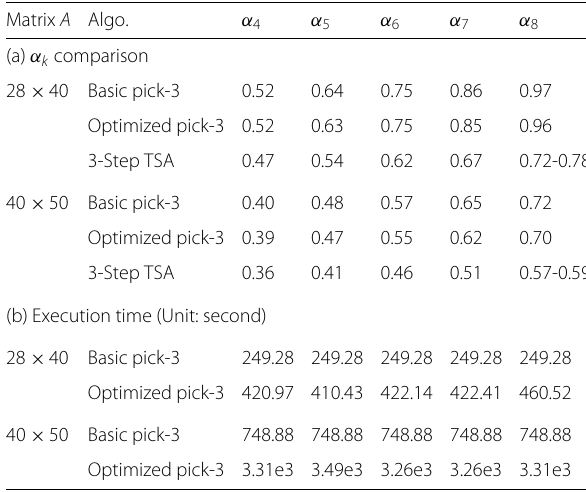
Table 4 α k comparison and execution time (Gaussian matrix) Matrix A Algo. α 4 α 5 α 6 α